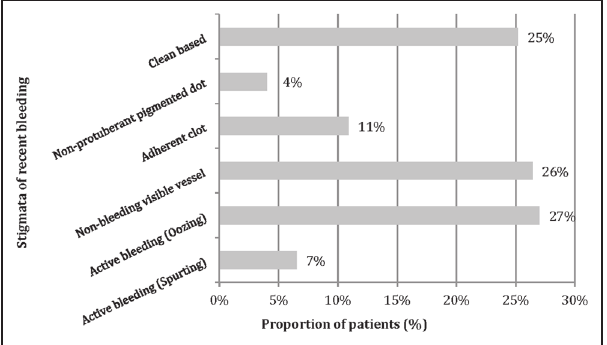
Figure 3) Distribution of stigmata of recent bleeding in nonvariceal upper gastrointestinal (ulcer and nonulcer lesions). Data representing stigmata from the lesion most likely to be the source of bleeding are